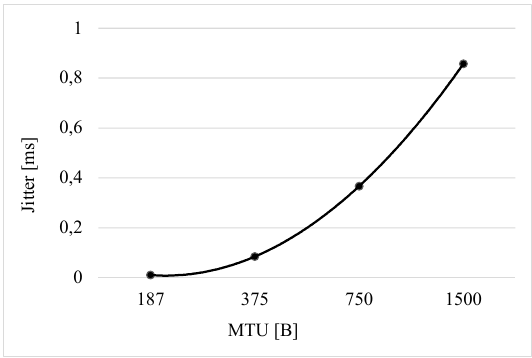
Figure 9. Dependency of network latency (jitter).